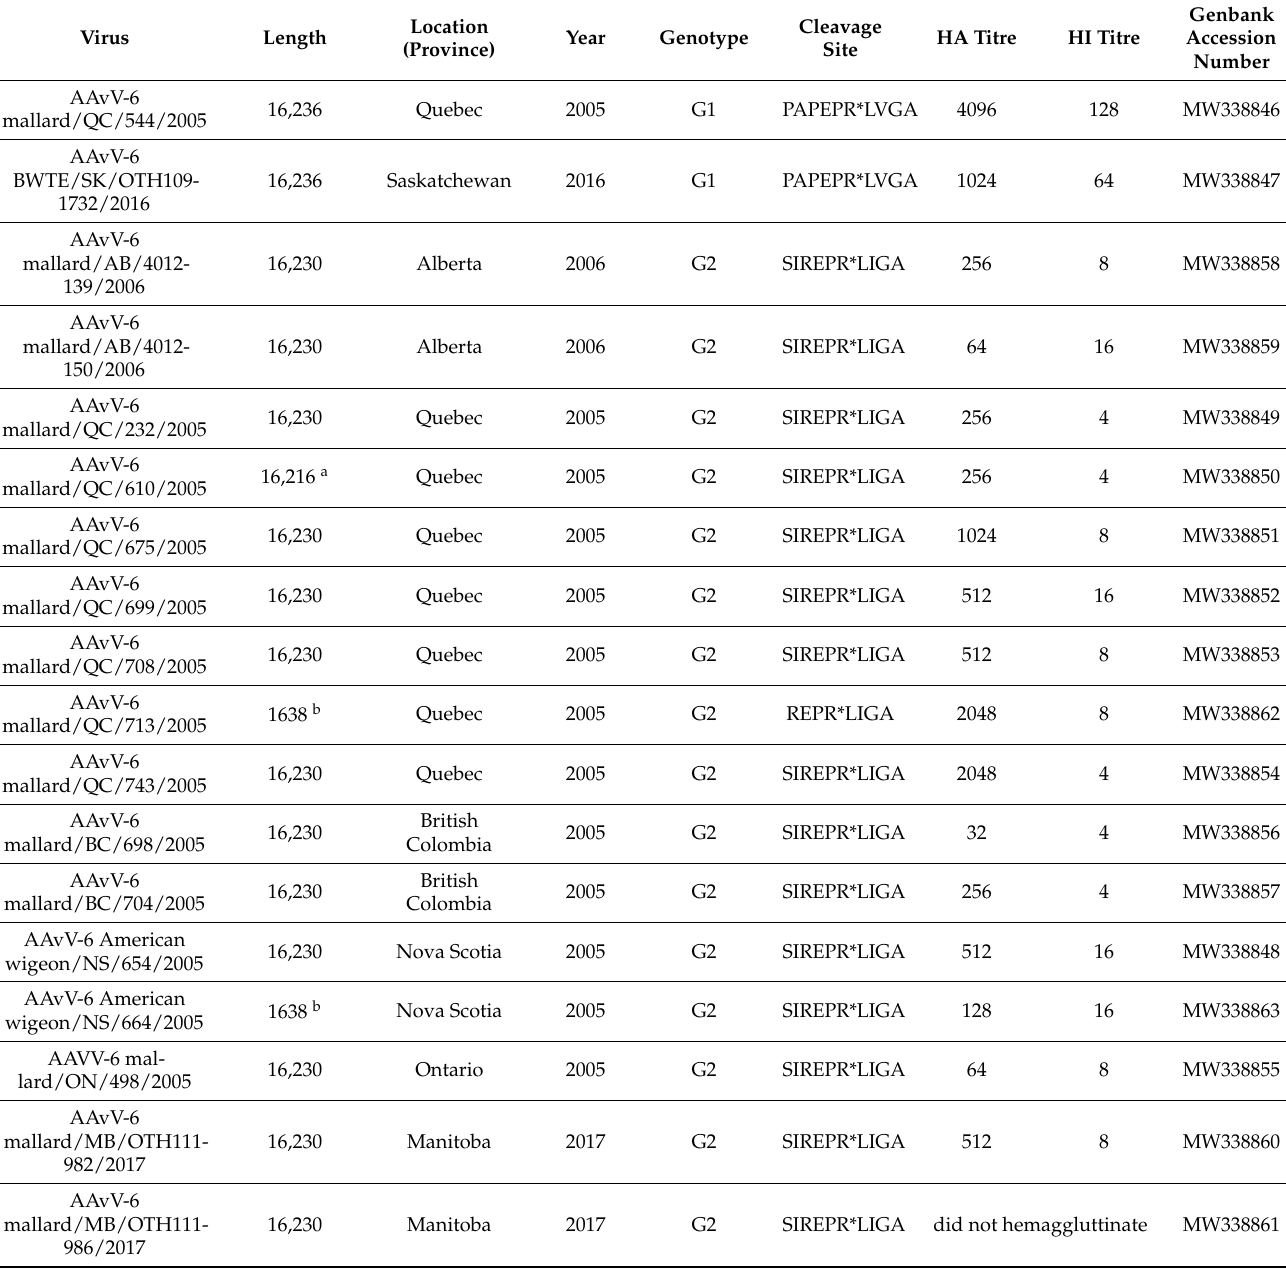
Table 3. Characterization of Canadian AAvV-6 viruses. HI titres were derived against reference anti-sera from the prototype virus AAvV-6 duck/Hong Kong/18/199/77. a virus is missing the 14 nucleotides of the genome, b represents viruses in which only the fusion gene has been